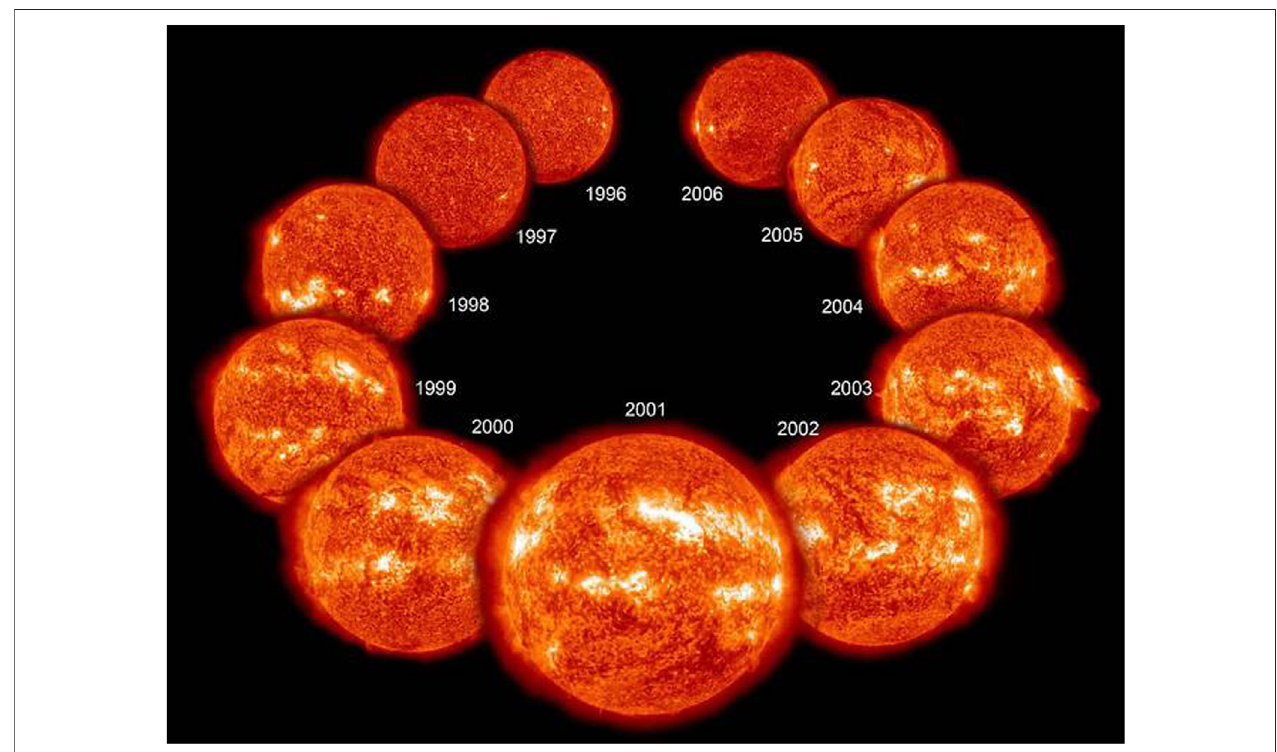
FIGURE 6 | A depiction of the solar cycle where, starting from a solar minimum in 1996, the image cycles through to solar maximum in 2001, then back to solar minimum in 2006, showing a full 11 years cycle. Note how the Sun shows little activity during solar minimum with very few active regions, while, during solar maximum various active regions, prominences, and fi laments can be seen. Image Credit: